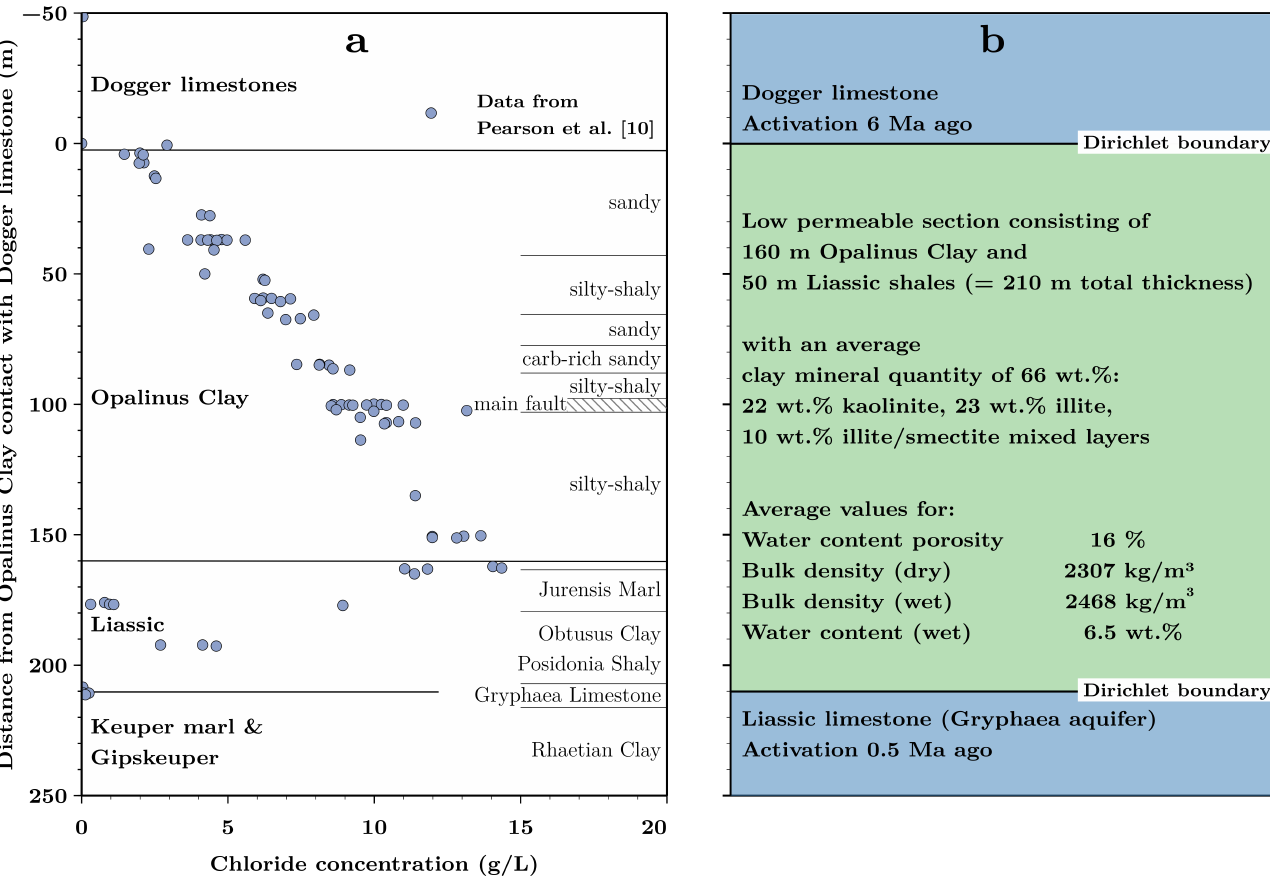
Figure 2. Profile of measured chloride concentrations at Mont Terri ( a ) is used to define the conceptual model ( b ) with boundary and initial conditions. The shape of the profile in the low permeable section (Liasic shales and Opalinus Clay) is the result of the time lag in fresh-water infiltration into the bounding aquifers, e.g., the Dogger and Liassic limestones, modified from Pearson et al. [10]. The y-axis is the distance perpendicular to the contact between Opalinus Clay and Dogger limestones.